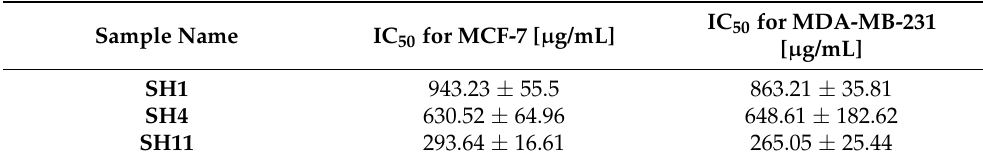
Table 4. The influence of SH1 , SH4 , and SH11 on the DNA biosynthesis in MCF-7 and MDA-MB-231 cell